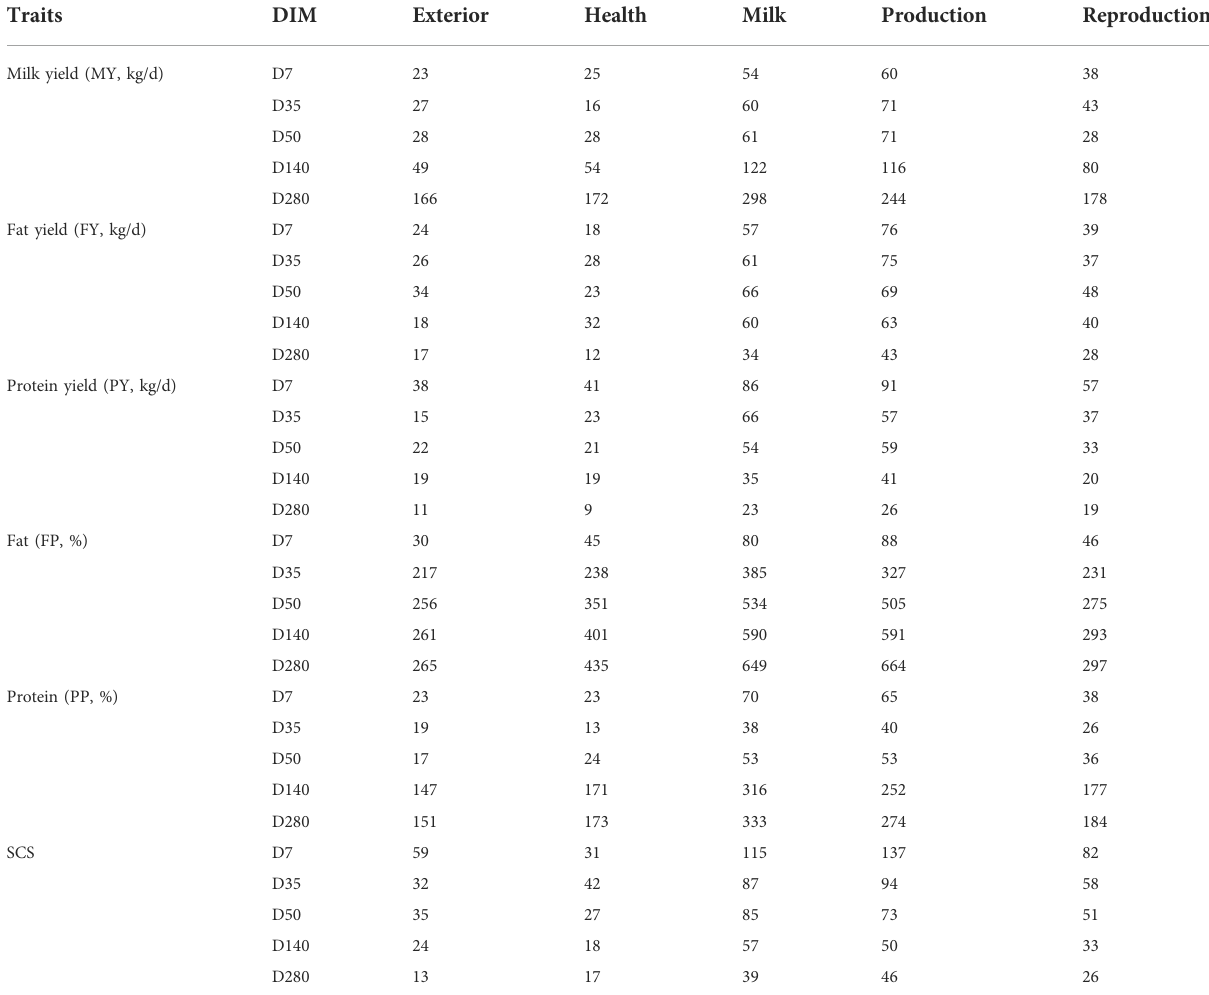
TABLE 3 Number of signi fi cant SNPs for QTL annotation with different DIM of milk production. Traits